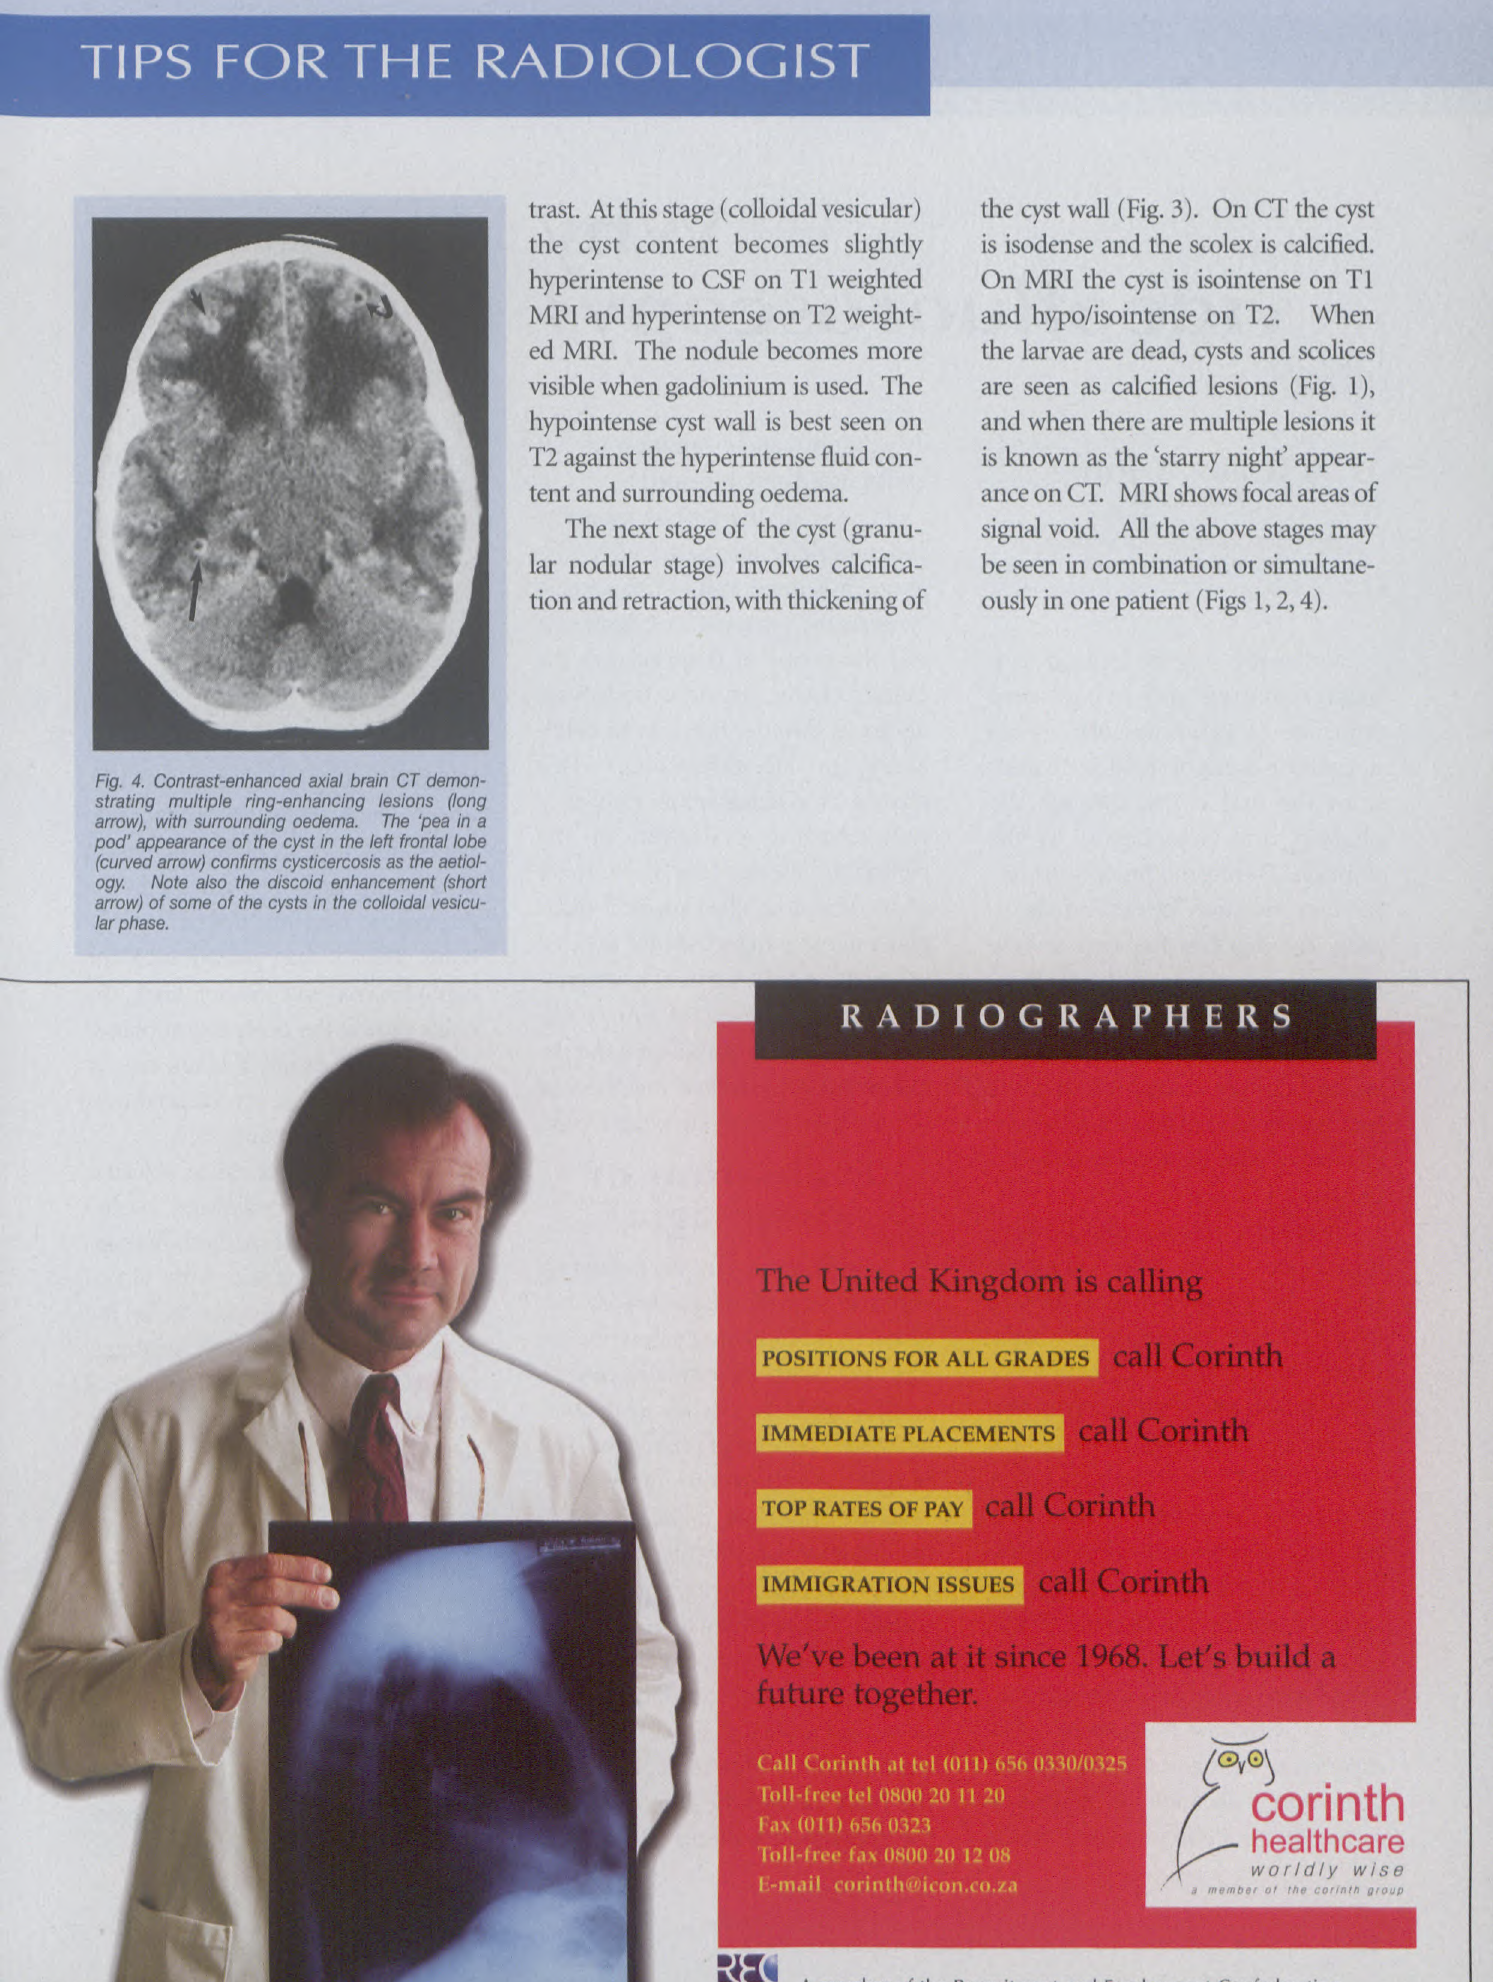
Fig. 4. Contrast-enhanced axial brain CT demon- strating multiple ring-enhancing lesions (long arrow), with surrounding oedema. The 'pea in a pod' appearance of the cyst in the left frontal lobe (curved arrow) confirms cysticercosis as the aetiol- ogy. Note also the discoid enhancement (short arrow) of some of the cysts in the colloidal vesicu- lar